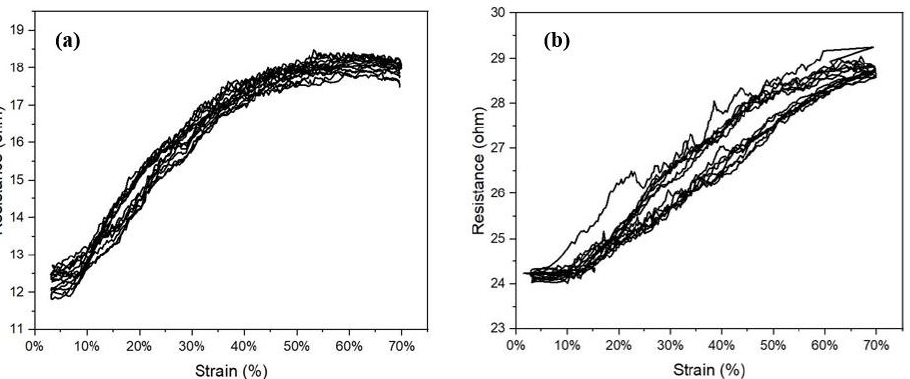
Figure 10. The electromechanical behaviour of the ( a ) NP 9 Y S sample at a 70% strain value over eight applied